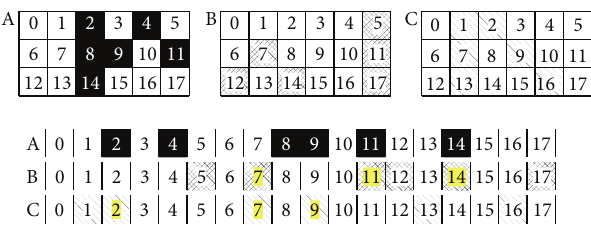
Figure 2: Standard torus QS example: node 𝐴 is built by picking the third column as its head and 3 randomly chosen slots from succeeding columns. 𝐵 is formed by selecting the sixth column and its tail from succeeding columns in a wrap-around manner. 𝐶 ’s head is the second column. 𝐴 and 𝐵 intersect at slots 11 and 14, 𝐵 and 𝐶 at slot 7, and 𝐴 and 𝐶 at slots 2 and